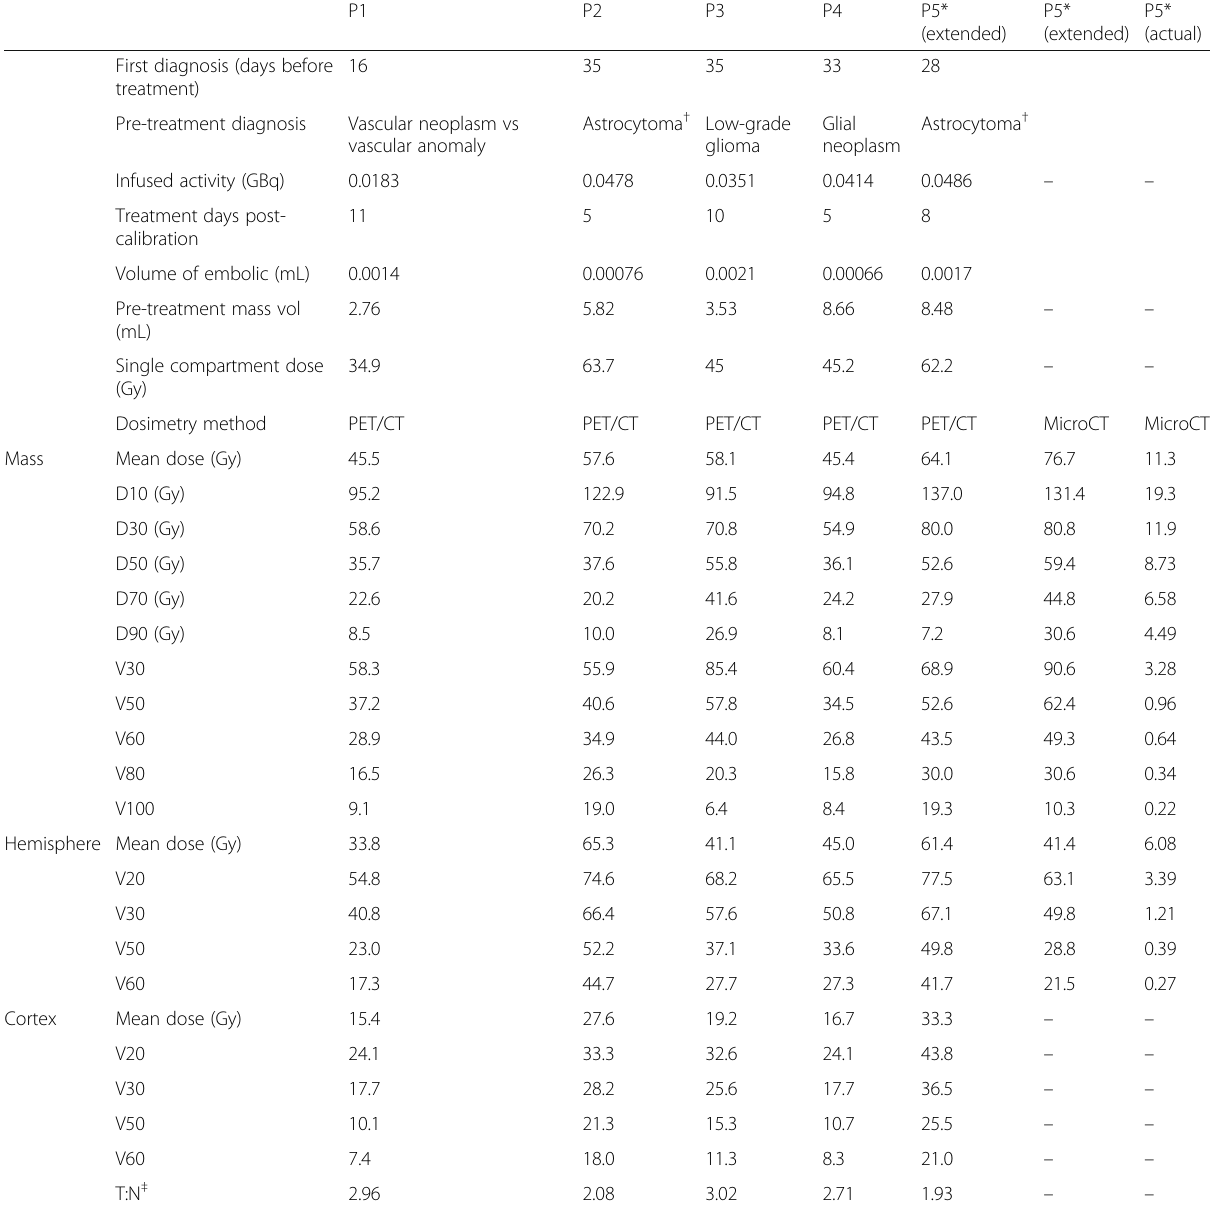
P5* P5* (extended) (extended) (actual)